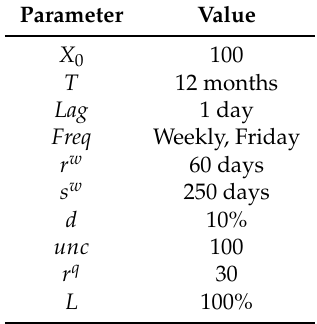
Table 9. Parameters used in the implementation of BL and NL as defined in the workflow for the foreign currency